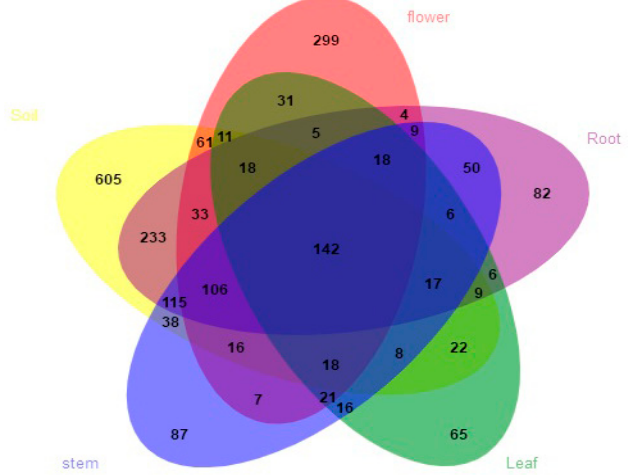
Figure 3. Venn diagram showing shared and unique fungal operational taxonomic units (OTUs) in each organ (flower, leaf, stem, root) and soil.